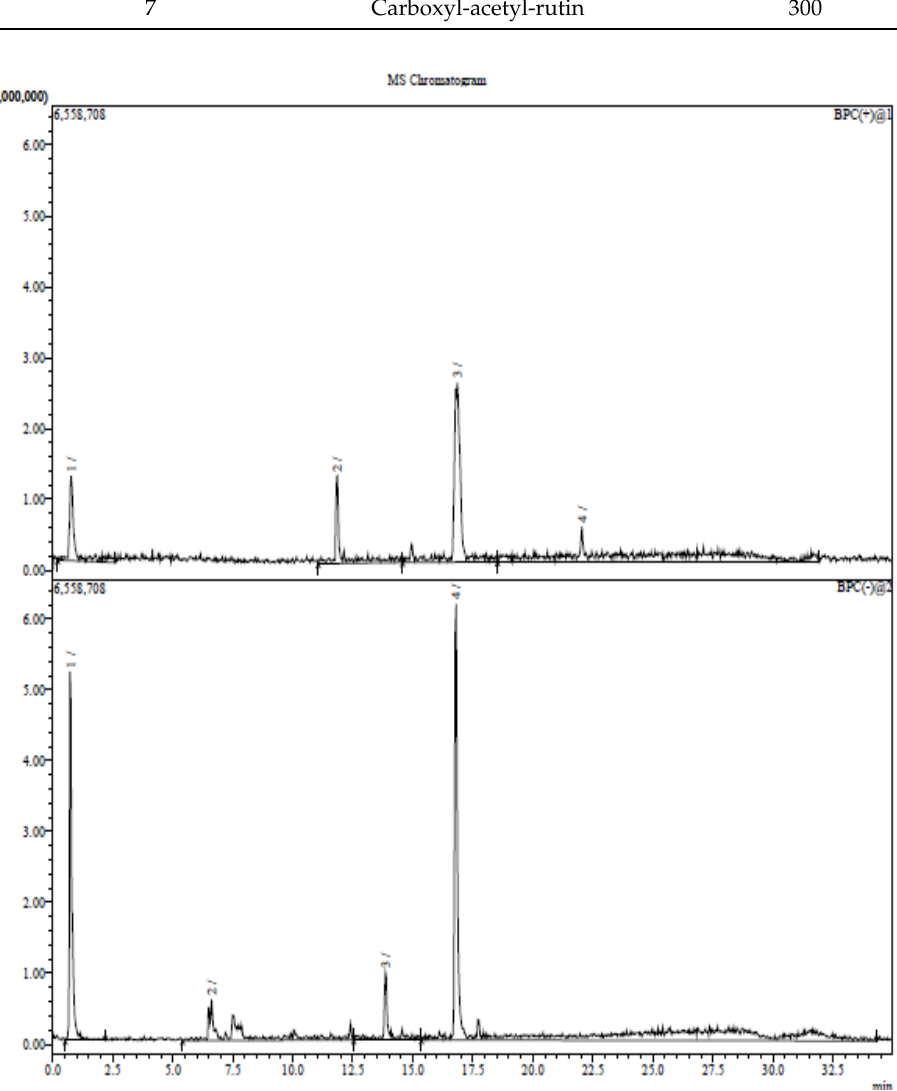
Figure 5. LC–MS chromatogram for the fractions of the Zantedeschia plant.